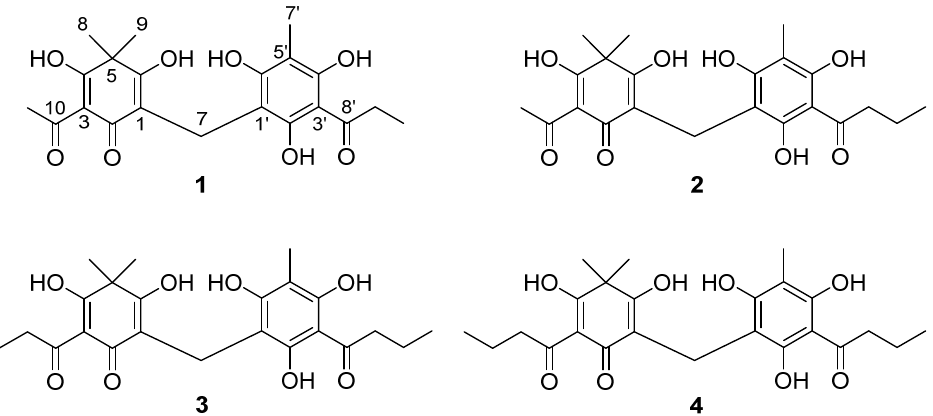
Figure 1. Chemical structures of isolated compounds 1 – 4 from rhizomes of Dryopteris crassirhizoma .